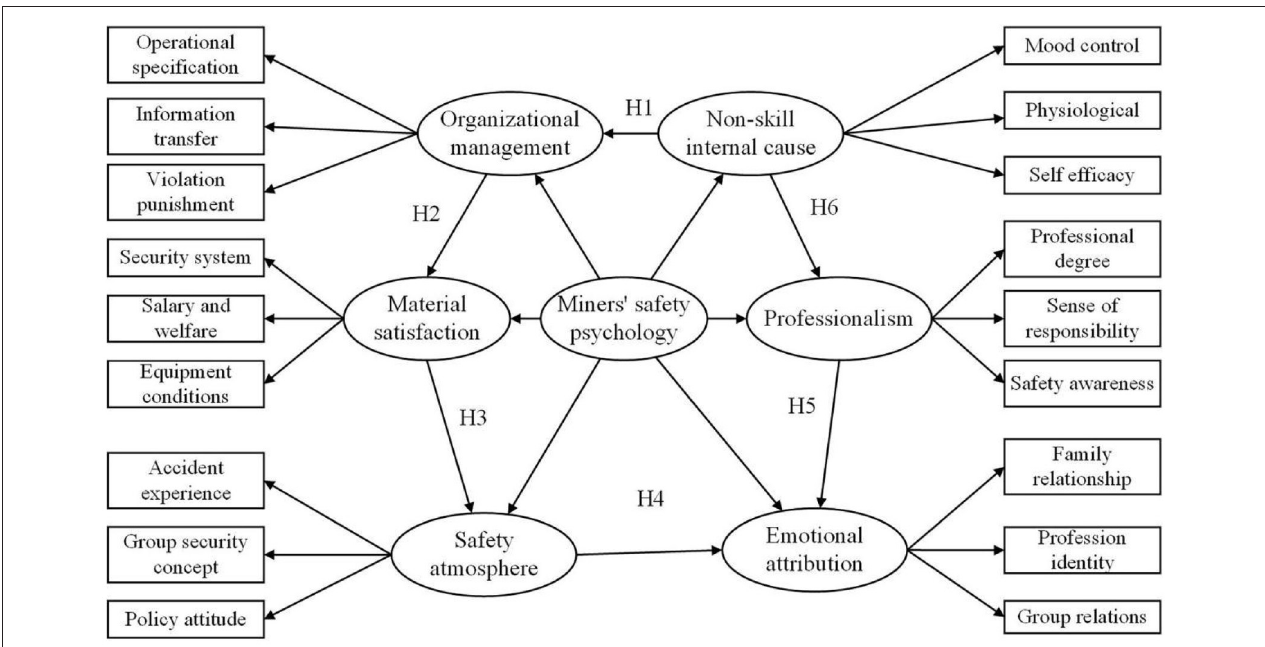
FIGURE 1 | Comprehensive model of three-level